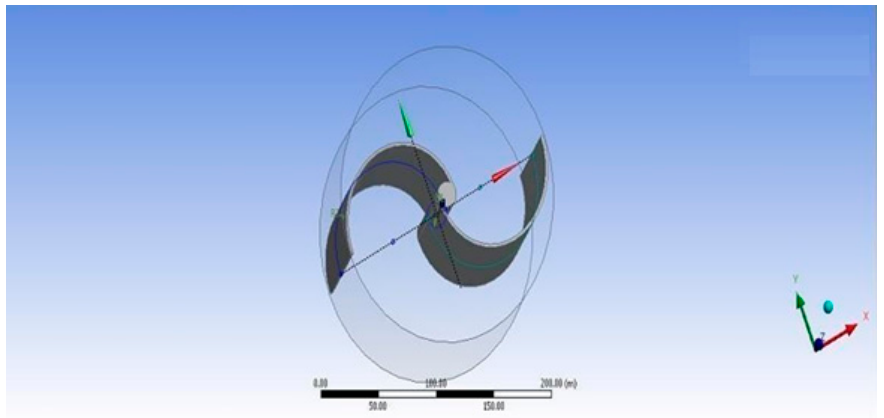
Figure 2. Schematic diagram of the Savonius rotor in 3D.